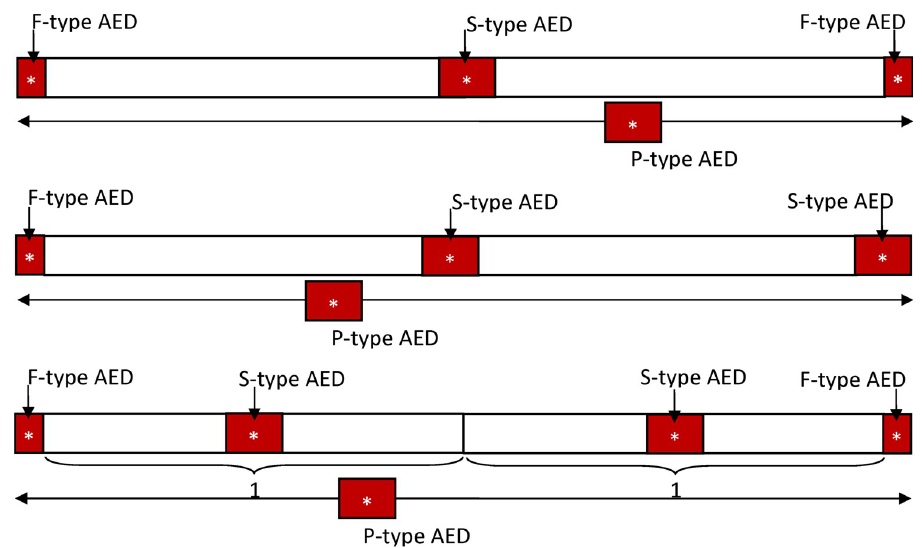
Fig 5. Illustration of optimal deployment for multiple AEDs. n F-type AEDs and n S-type AEDs with one F S patrolling (P-type) AED, where ( n F , n S ) = (2,1), and (2,2). Again, here, we only indicate the hot zones of each AED. With a P-type AED, we need to place two AEDs toward the two end locations with their hot zones entirely contained in the confined space. In the case of ( n , n ) = (2,1), the two F-type AEDs are placed toward the end locations, and the F S S-type AED is placed at the center of the remaining space. In the case of ( n F , n S ) = (1,2), we place one F-type AED and , one S-type AED toward the end locations and one S-type AED at the center of the remaining space. In the case of ( n F n S ) = (2,2), again, we place two F-type AEDs toward the end locations. The remaining space is then divided into two parts with a 1 -to-1 length ratio. The two S-type AEDs are then placed at the center of these two parts.